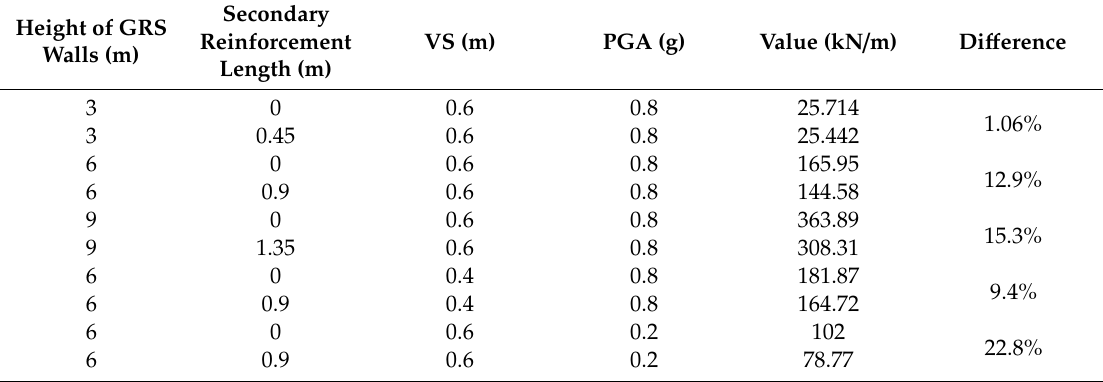
Table 7. Sum of the maximum reinforcement loads of walls in each primary reinforcement layer.